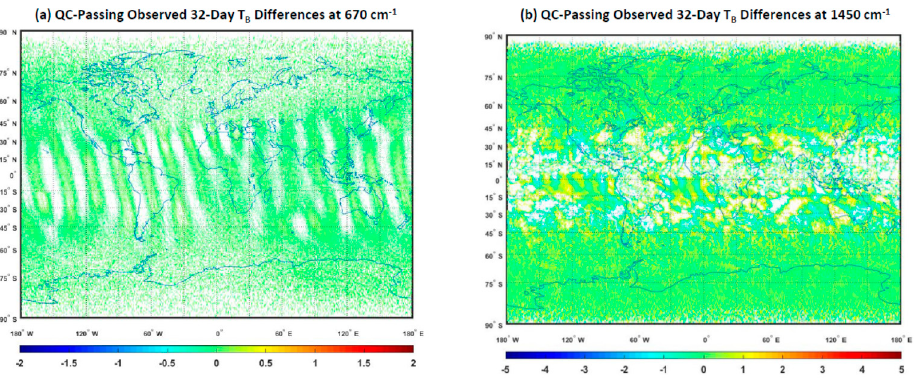
Figure 6. Global distributions of 32-day-averaged brightness temperature differences at 670 and 1450 cm − 1 (NOAA-20 CrIS – SNPP CrIS) after the QC is applied, which are the same as Figure 3 except for the QC applied to remove all pixels falling in the QC. ( a ) 670 cm − 1 . ( b ) 1450 cm − 1 .